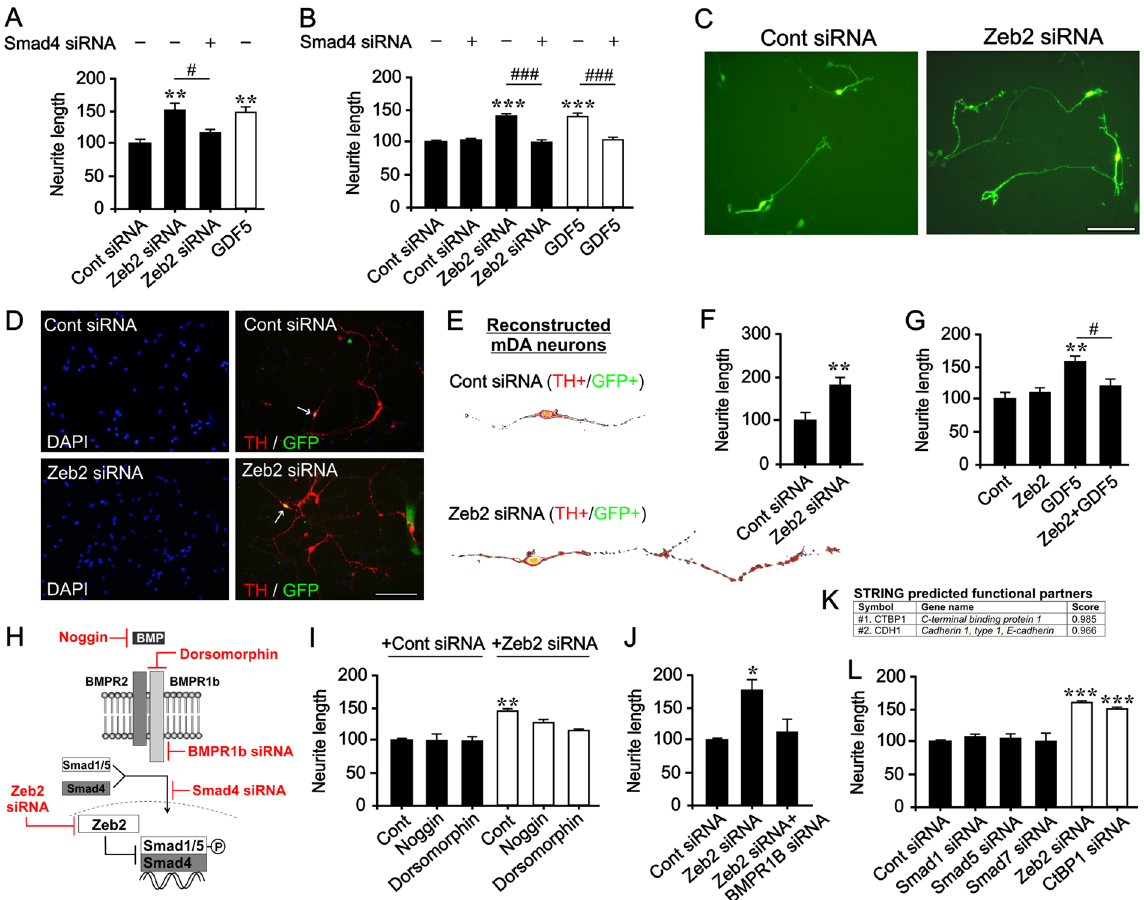
Figure 3. Zeb2 is an endogenous negative regulator of Smad-dependent neurite growth. ( A , B ) Graphs of neurite length relative to control in cultures of ( A ) SH-SY5Y and ( B ) E14 VM neurons transfected with Zeb2 - siRNA or a control siRNA with or without a Smad4 -siRNA and cultured for 72 h. Cells were treated with 100 ng/ml GDF5 as a positive control. ( C , D ) Photomicrographs of ( C ) GFP + neurons and ( D ) mDA neurons (TH + /GFP + ) in cultures of E14 rat VM neurons transfected with Zeb2 -siRNA or a control siRNA at 72 h. ( E ) Reconstructed mDA neurons and ( F ) relative neurite length of mDA neurons from the experiment outlined in ( D ). ( G ) Graph of relative neurite length in cultures of E14 VM neurons transfected with Zeb2 or control expression vectors cultured with or without 100 ng/ml GDF5 for 72 h. ( H ) Schematic of experimental approaches. ( I , J ) Graph of neurite length in cultures of E14 VM neurons transfected with Zeb2 -siRNA or a control siRNA and cultured with noggin or dorsomorphin ( I ) or a control siRNA and BMPR1b -siRNA ( J ), after 72 h. ( K ) STRING score showing the two functional binding partners of Zeb2. ( L ) Graph of neurite length in cultures of E14 VM neurons transfected with control siRNA or Smad1 , Smad5 , Smad7 , Zeb2 or CtBP1 siRNA and cultured for 72 h. (n = 3; * P < 0.05, ** P < 0.01, **** P < 0.0001 vs. control; t-test or ANOVA with post hoc Tukey’s test; # P < 0.05; ### P < 0.001). All data are the mean + SEM. Scale bar = 100 µ